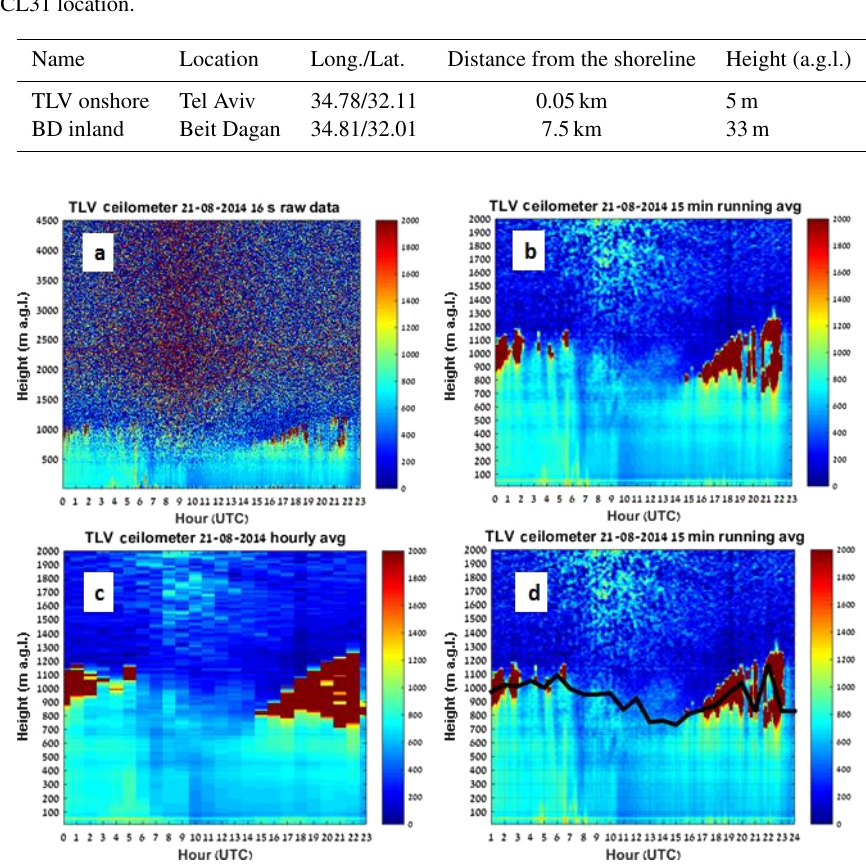
Figure 2. Stages of daily ceilometer evaluation. (a) Raw data plot based on attenuated backscatter (units 10 − 6 m − 1 sr − 1 ) , taken every 16s; (b) 15min running average plot to reduce noise; (c) hourly averaged profiles; (d) the assessed diurnal MLH (black line) overlaying panel (b) for hours